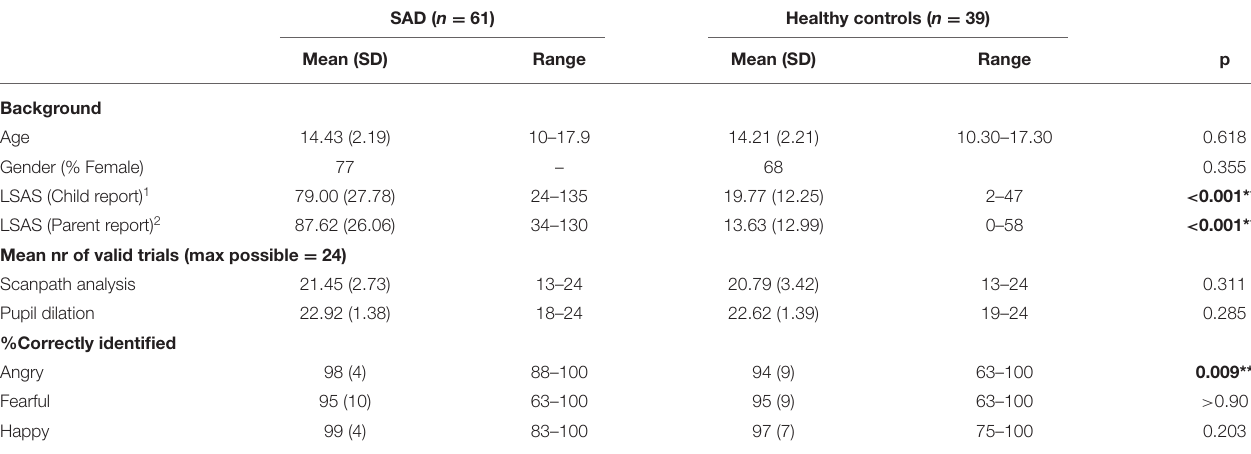
TABLE 1 | Demographics, clinical characteristics and number of valid